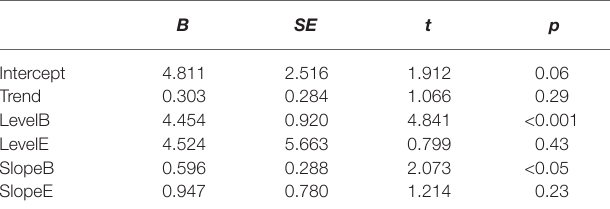
TABLE 4 | Regression model for the number of words read correctly (level-2- analysis). B SE t p